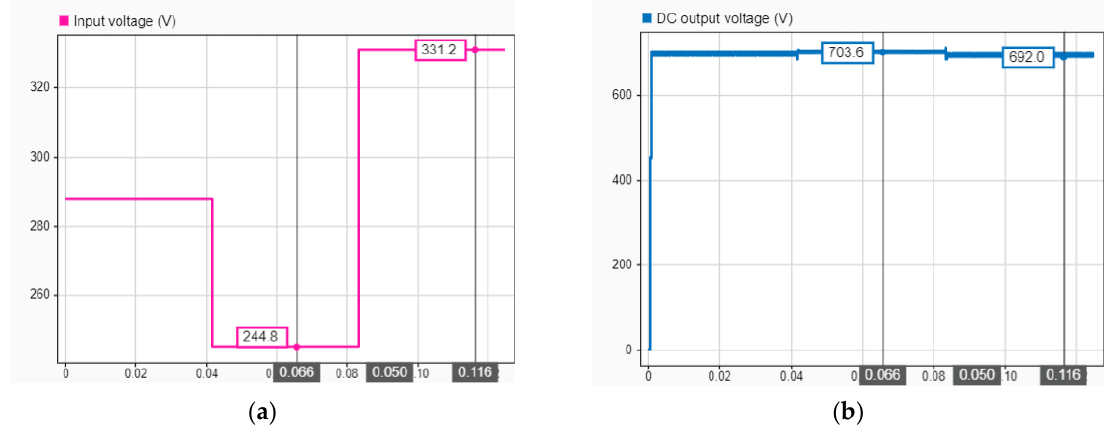
Figure 12. Input voltage disturbance response of 80 kW DAB DC-DC converter under optimal TrgPS operation, L = 1.57 µH: ( a ) input voltage disturbances; ( b ) DC bus output voltage response.